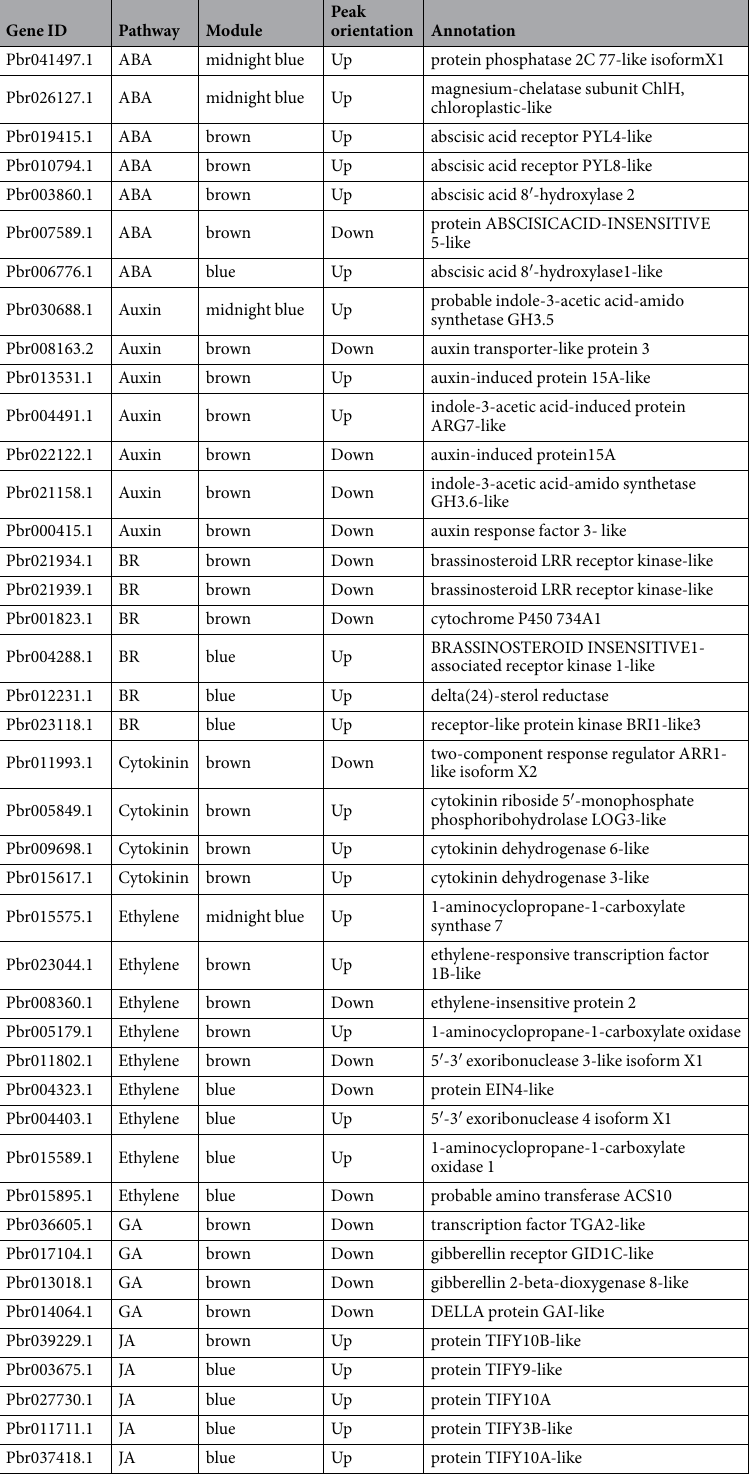
Table 2. Selected differentially expressed genes related to the phytohormone biosynthesis and signalling pathways during light-responsive